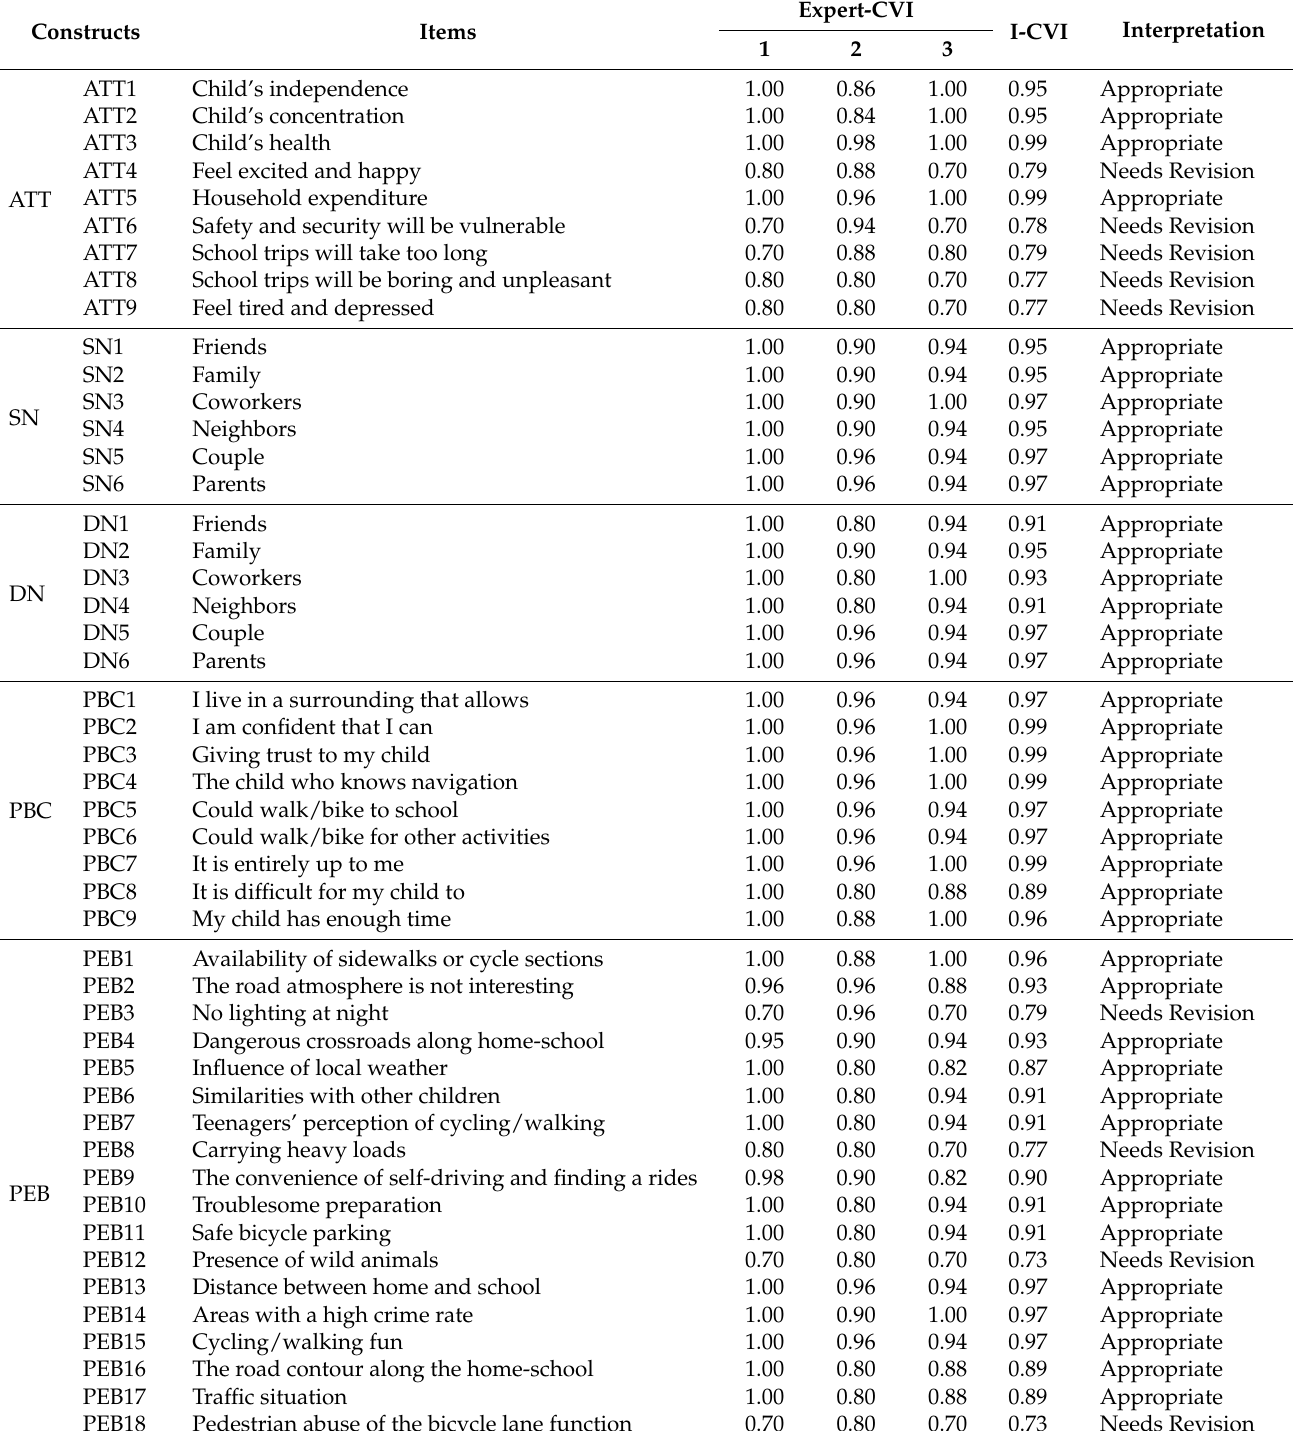
Table A1. Calculation of I-CVI and S-CVI/Ave for items of